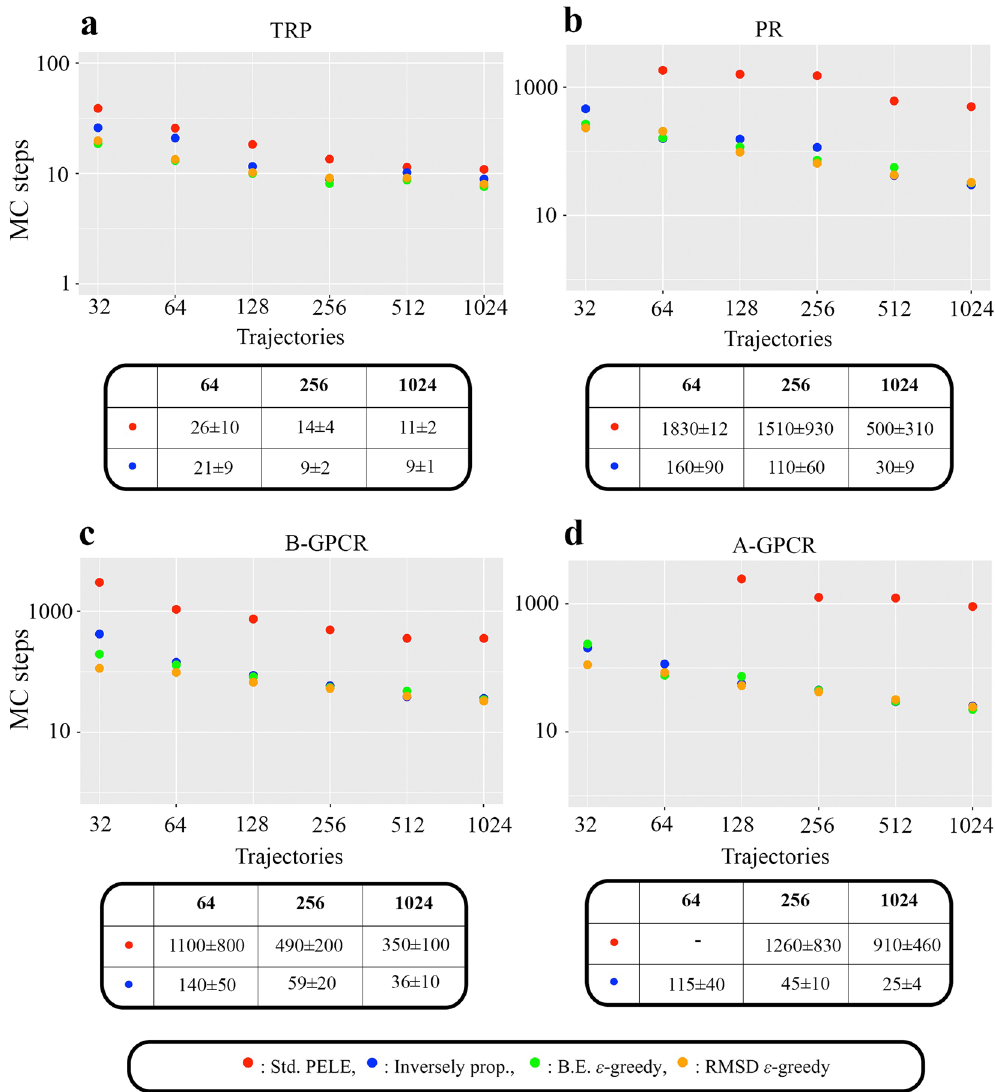
Figure 3. Binding times for all systems and MC techniques. ( a ) Number of steps for observing a binding event against the number of trajectories (processors) for the TRP system, using the standard PELE (in red) and the adaptive-PELE with the inversely proportional (in blue) and the ε -greedy guided strategies with binding energy (in green) and RMSD (in orange). Actual data (MC steps) with their standard deviation for three different sets of processors is shown at the bottom table inset for the standard PELE and the inversely proportional adaptive- PELE methods. ( b–d ) Analogous plots for PR, B-GPRC, and A-GPCR. A complete list of all data is shown in Supplementary